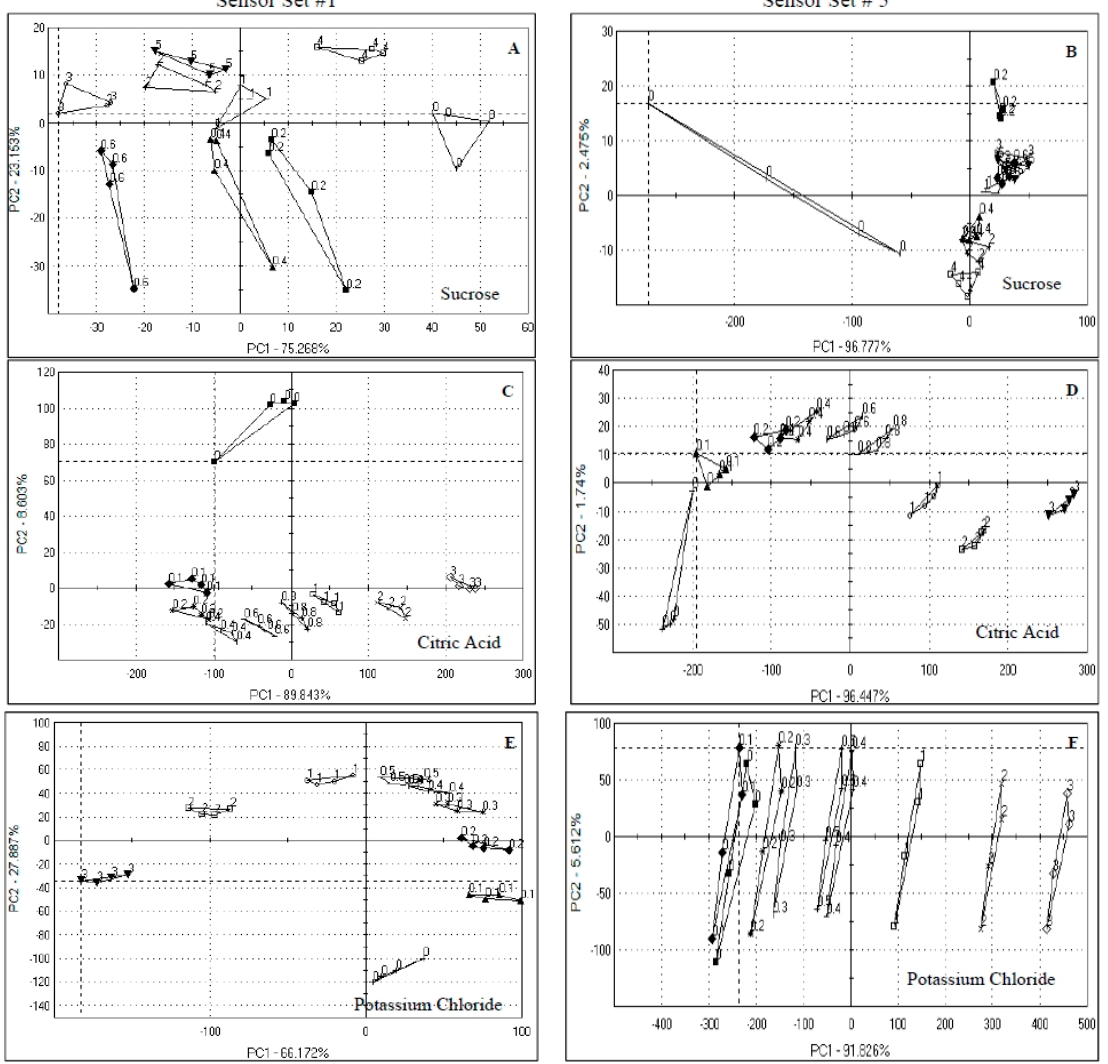
Figure 1. Principal component analysis of orange juice spiked with sucrose, citric acid and potassium chloride. Numbers in the graphs indicate the concentrations used (g/100 mL juice). Samples presented were analyzed by sensor set #1 and 5. ( A ) Sucrose by Set #1; ( B ) Sucrose by Set #5; ( C ) Citric acid by Set #1; ( D ) Citric acid by Set #5; ( E ) Potassium chloride by Set #1; ( F ) Potassium chloride by Set #5.